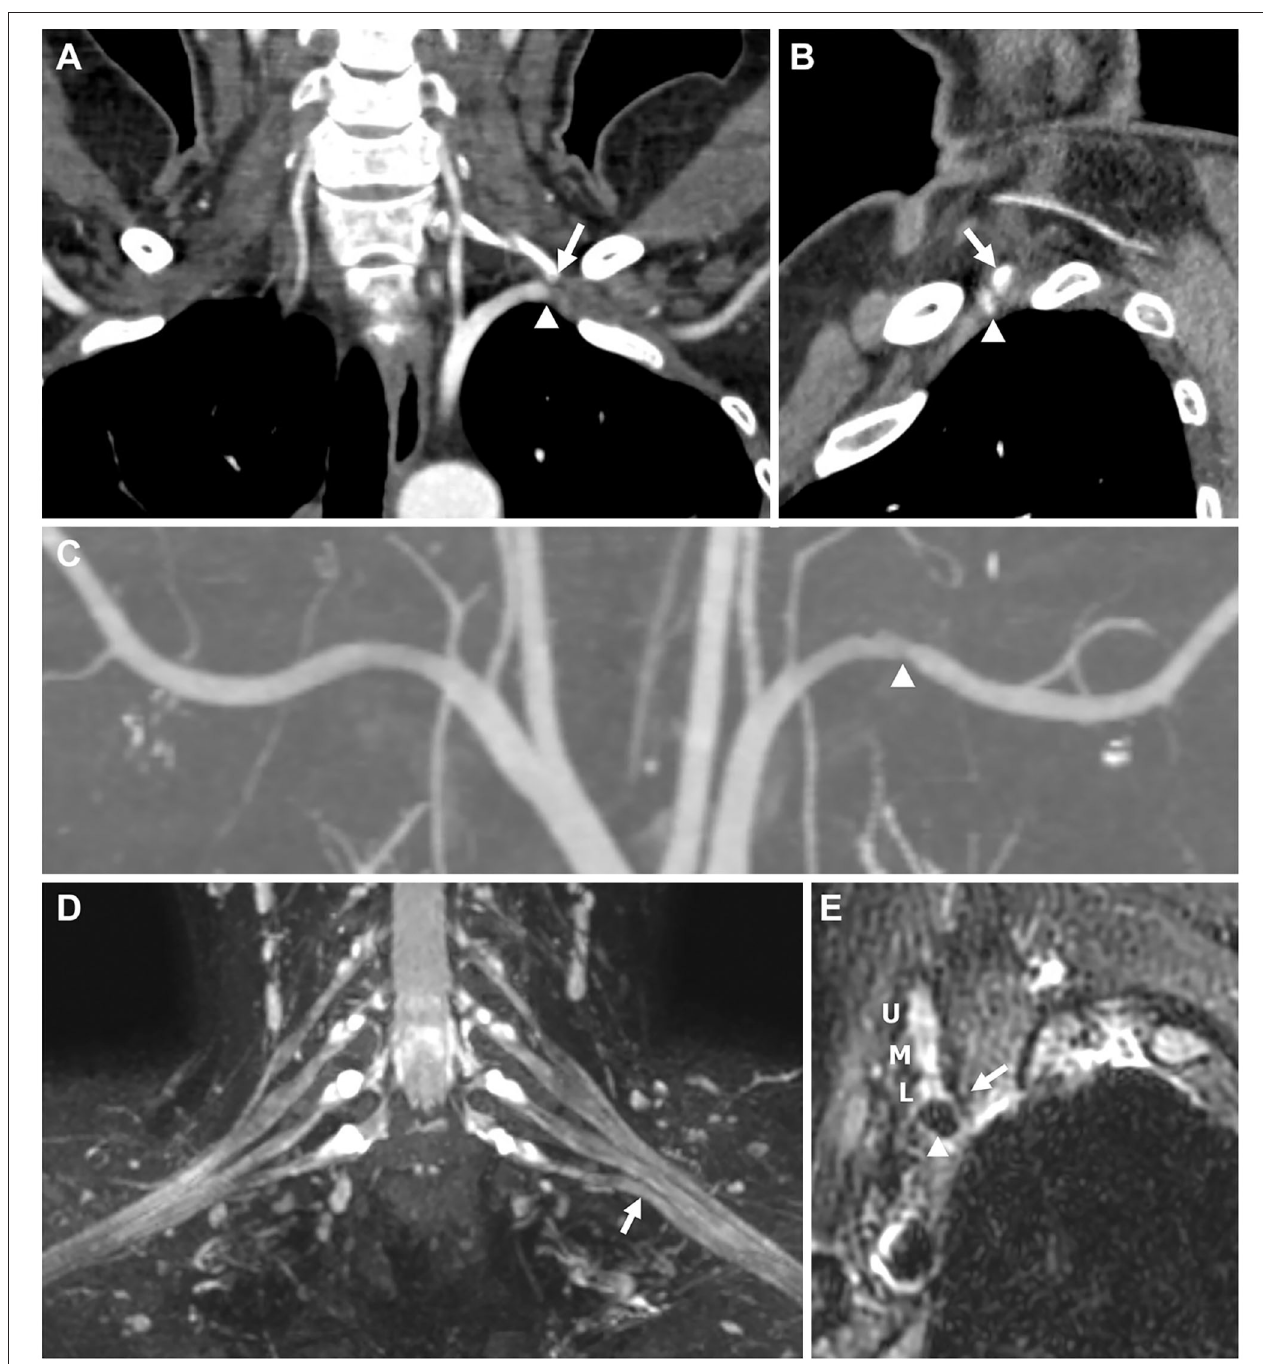
FIGURE 1 | Imaging findings for Patient 1. (A,B) Computed tomography (CT) angiography performed with 180 ◦ shoulder abduction. (C–E) Brachial plexus magnetic resonance imaging (MRI). (A) Coronal image showing the tip of the left cervical rib arising from the C7 vertebra (arrow) abutting the left subclavian artery (arrowhead). (B) Sagittal image showing the tip (arrow) compressing the subclavian artery (arrowhead) in the anterior direction, causing stenosis. (C) Coronal maximum intensity projection (MIP) image showing stenosis of the left subclavian artery (arrowhead). (D) Coronal T2-weighted fat suppression MIP image showing upward angulation of the lower trunk (arrow), presumably caused by the anterior tip of the cervical rib, although not shown in this image. Swelling or abnormal signal intensity of the brachial plexus was not definite. (E) Oblique sagittal T2-weighted fat suppression image showing the spatial associations of the anterior tip of the cervical rib (arrow), brachial plexus (U, upper trunk; M, middle trunk; L, lower trunk), and subclavian artery (arrowhead).